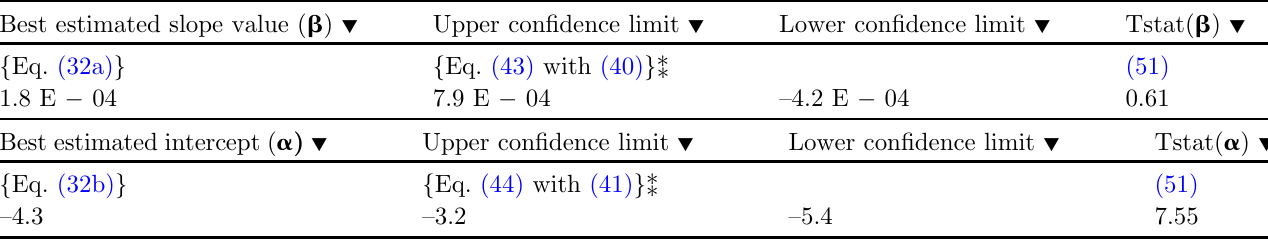
Table 9. Example 5. FAC-1; system C; linear regression analysis results; slope & intercept. Best estimated slope value ( b )